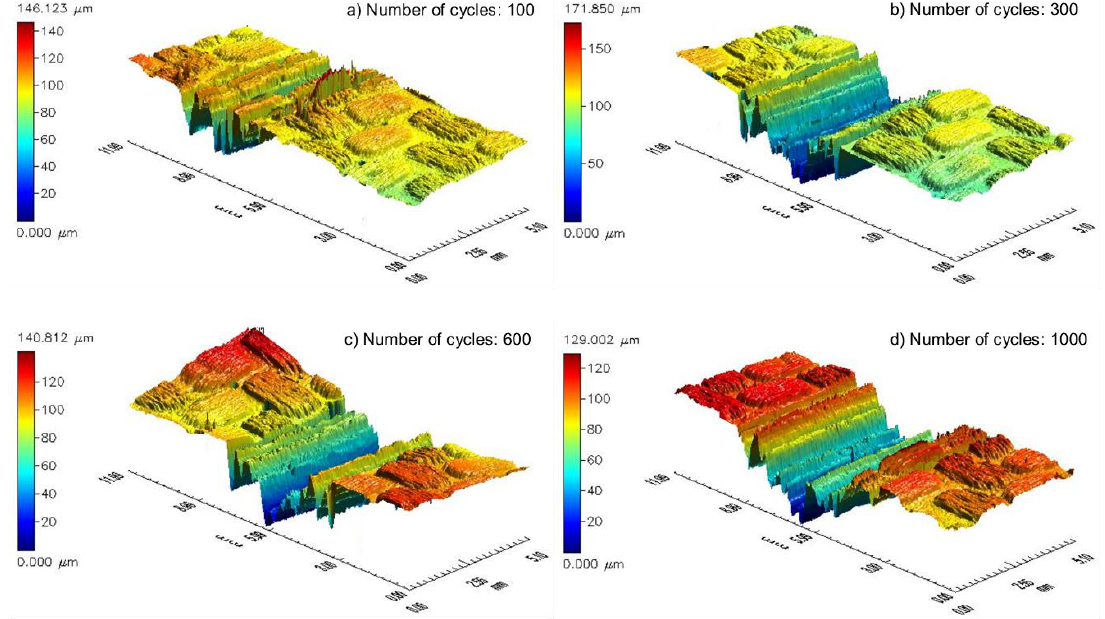
Figure 6. Exemplary maps of the surface sample (six months of weathering) after ( a ) 100, ( b ) 300, ( c ) 600, and ( d ) 1000 cycles of dry abrasive wear.